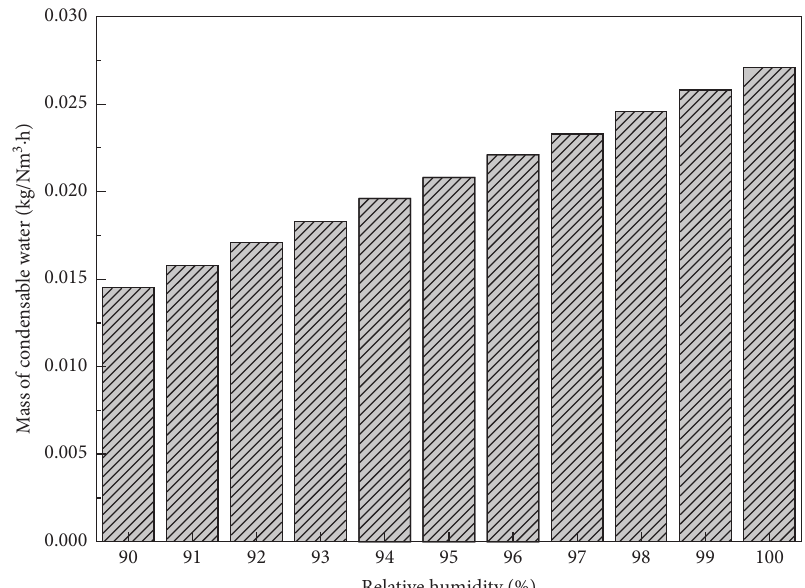
Figure 11: Effect of the relative humidity on the mass of condensable water.